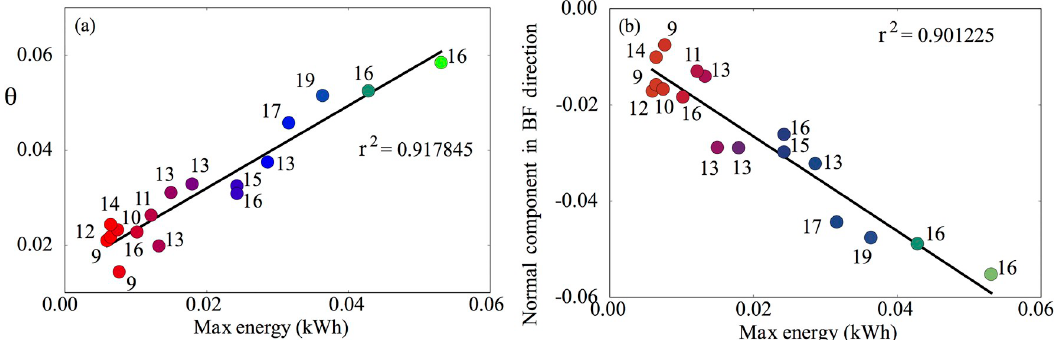
Fig 8. The first principal component obtained via PCA accounts for over 90% of the variation in test performance. (b) Similar levels of variance are accounted for by taking only the normal component of the first principal component, θ , in the breathing frequency